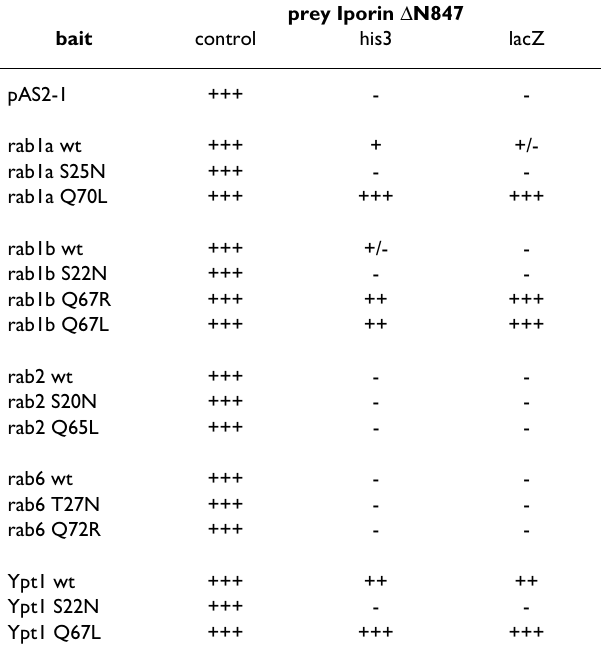
Table 1: Interaction of Iporin ∆ N847 with different rab proteins/